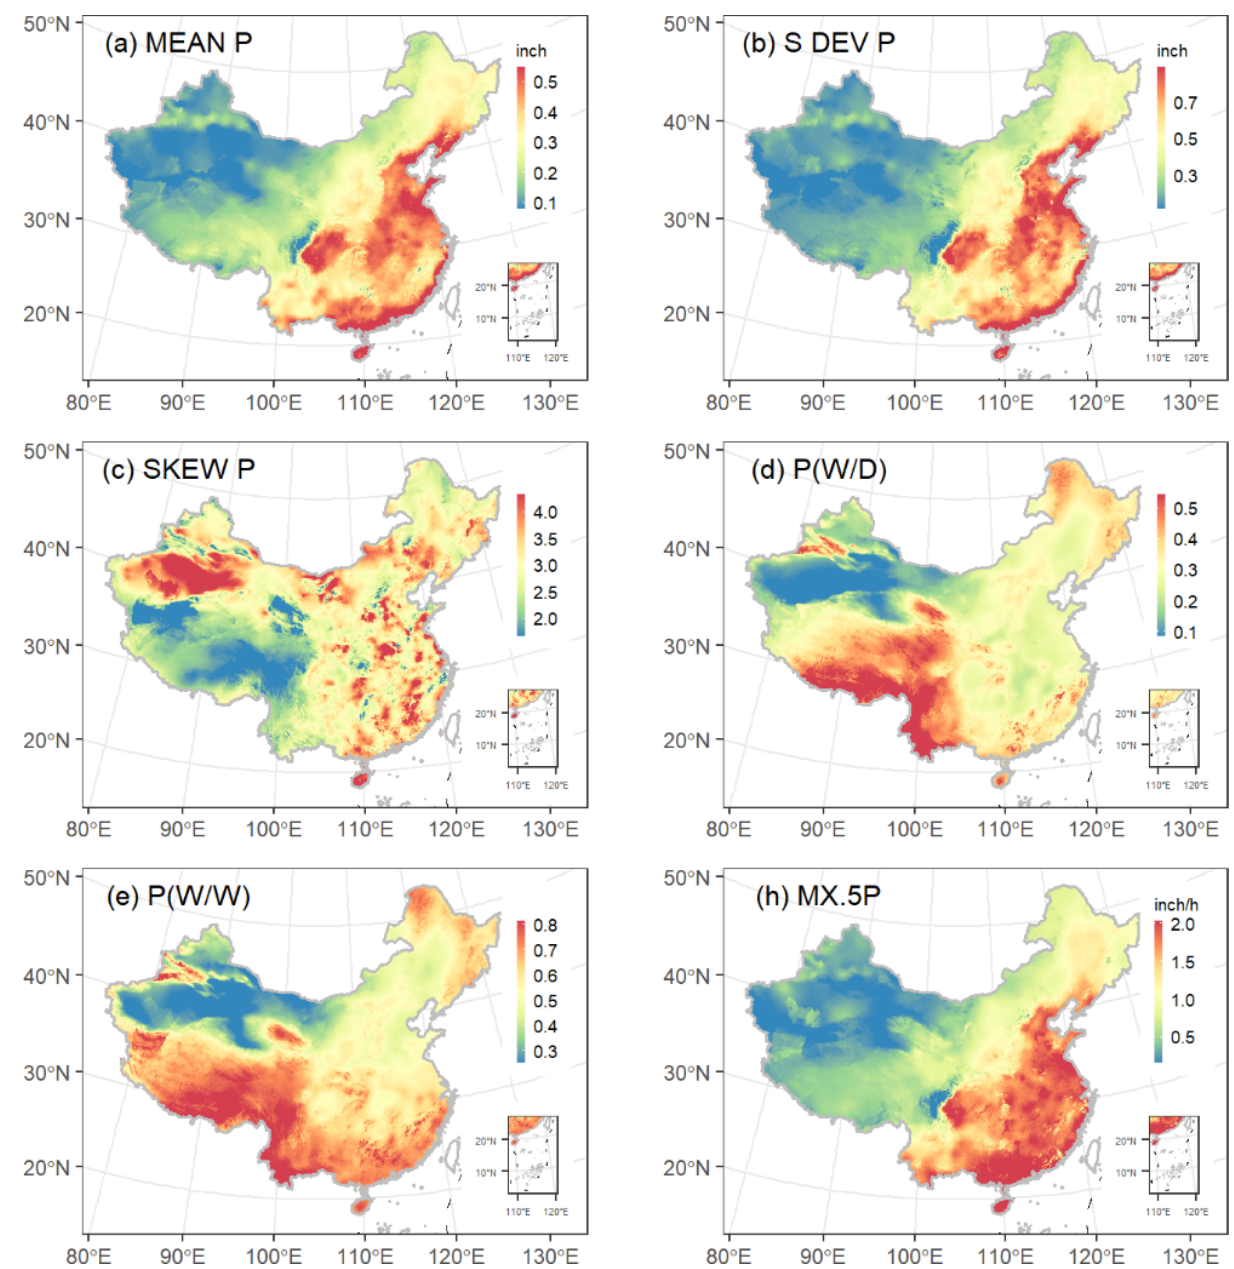
Figure 4. Map of the study area showing the spatial distribution of CLIGEN precipitation-related parameters of mainland China in August. All parameters were regionalized using universal